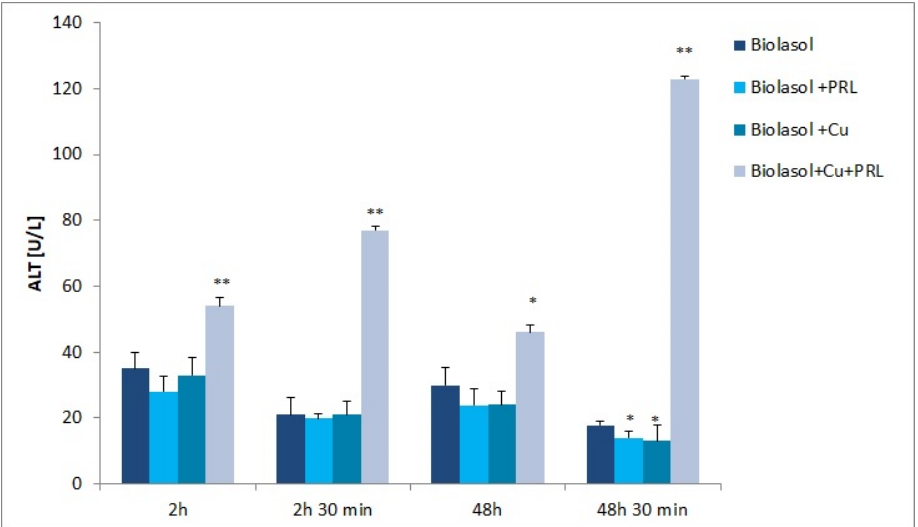
Figure 1. ALT activity in collected perfusate samples. The values are expressed as mean ± SEM. Data were analysed by one-way ANOVA and Bonferroni post hoc tests; n = 10; * p < 0.05; ** p < 0.01 compared to the control group (Biolasol).